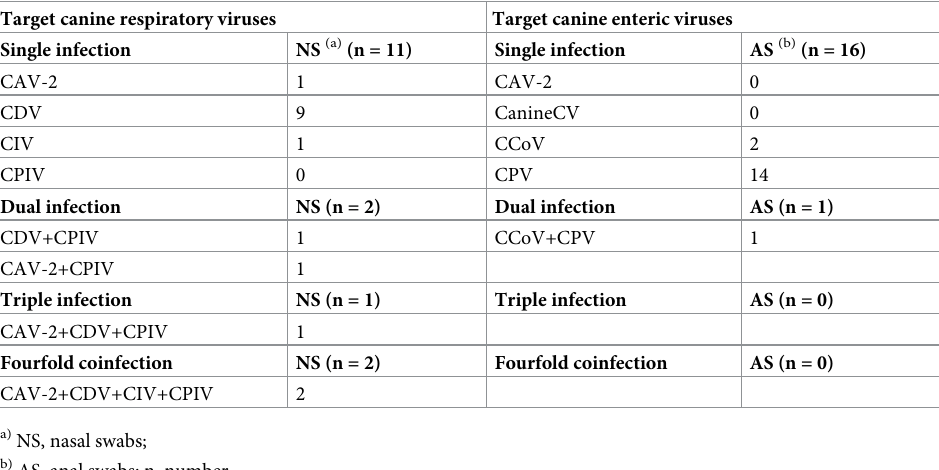
Table 2. Detection of CRV and CEV in clinical samples using